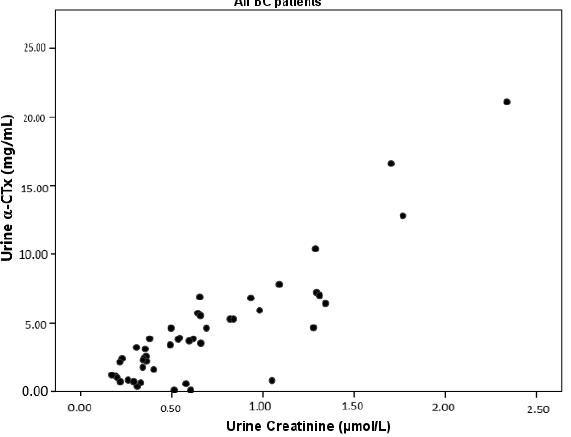
Figure 3 . Correlation between α-CTx levels and urine creatinine for all breast cancer patients.